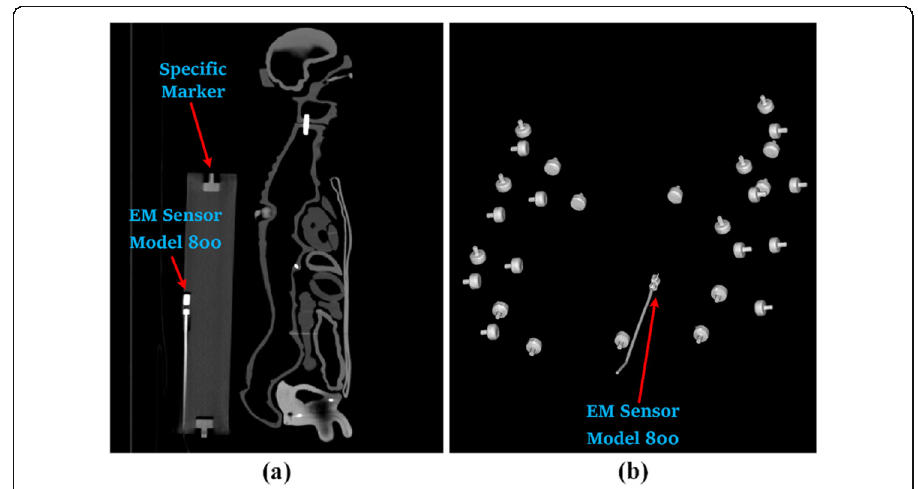
Fig. 5 CT images of the specific markers. a An example of a 2D image. b The 3D reconstruction